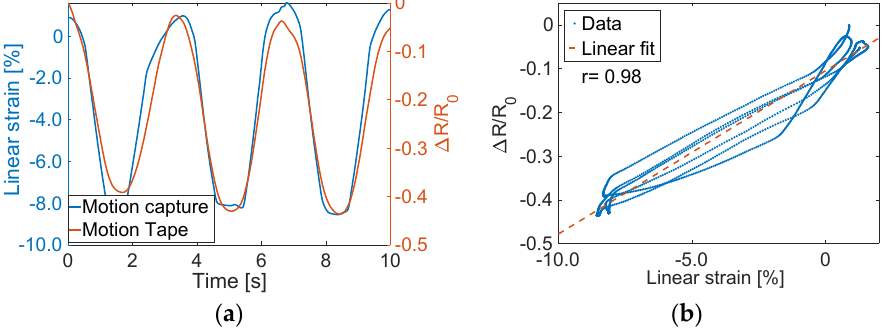
Figure 8. ( a ) The normalized change in resistance time history of Motion Tape on the calf is overlaid with linear strains estimated from optical motion capture. ( b ) Linear and low-hysteresis compressive strain sensing was confirmed.